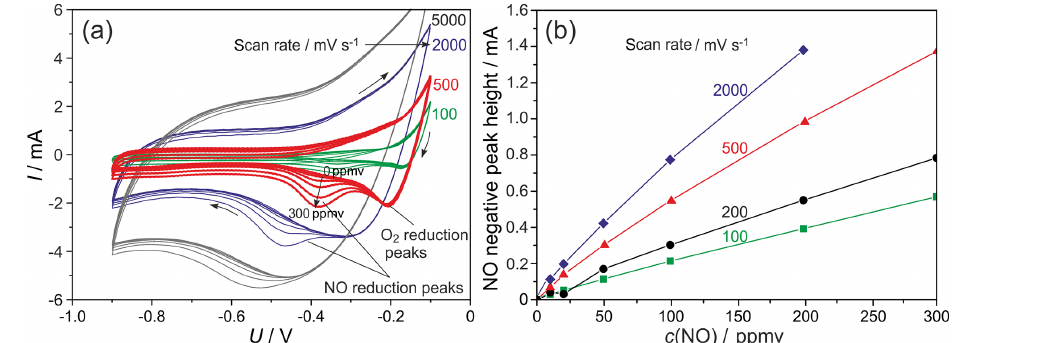
Figure 2. Cyclic voltammograms (a) and NO peak heights (b) at different potential scan rates and NO concentrations. Sensor temperature T = 650 ◦ C; flow rate = 10sccm; c (O 2 ) = 0 . 2ppmv.